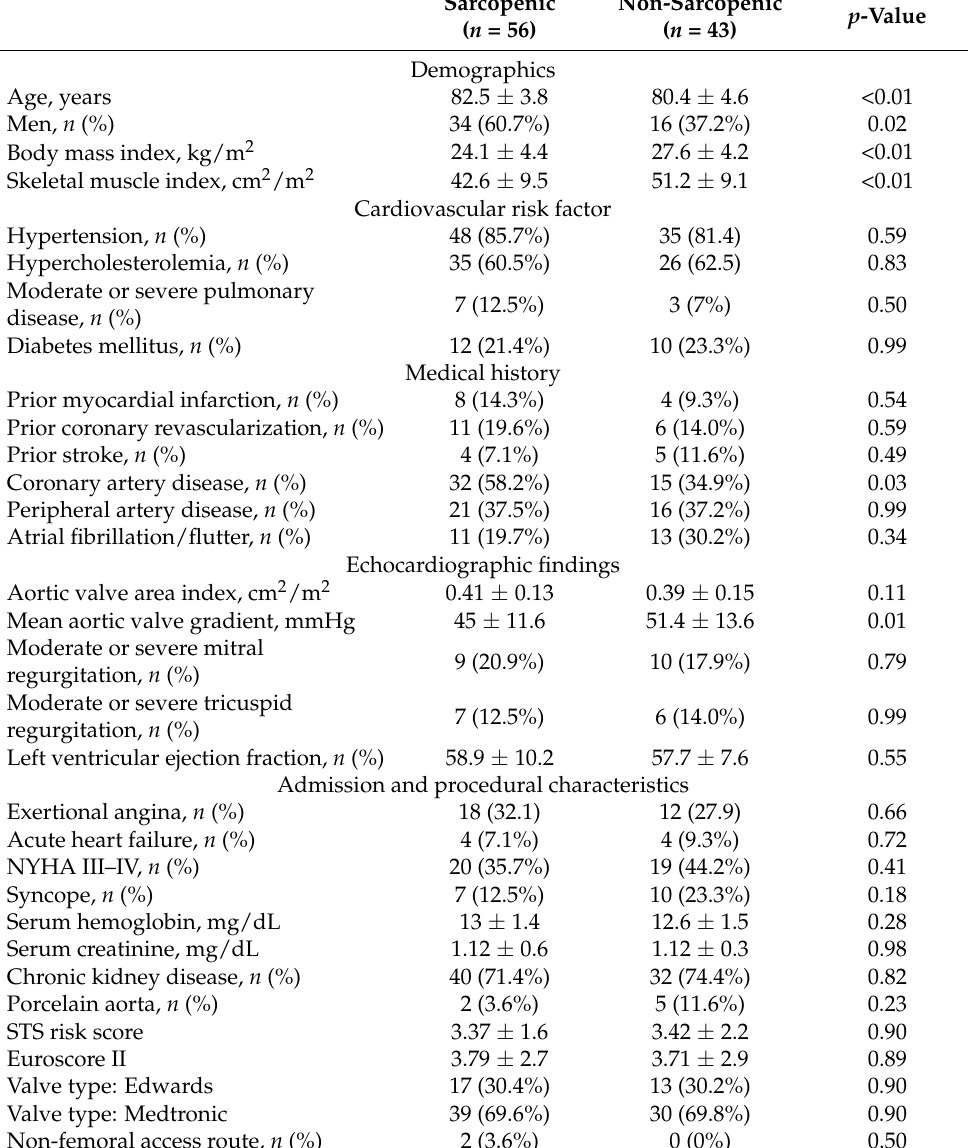
Table 1. Baseline characteristics of the study population pre-TAVR.